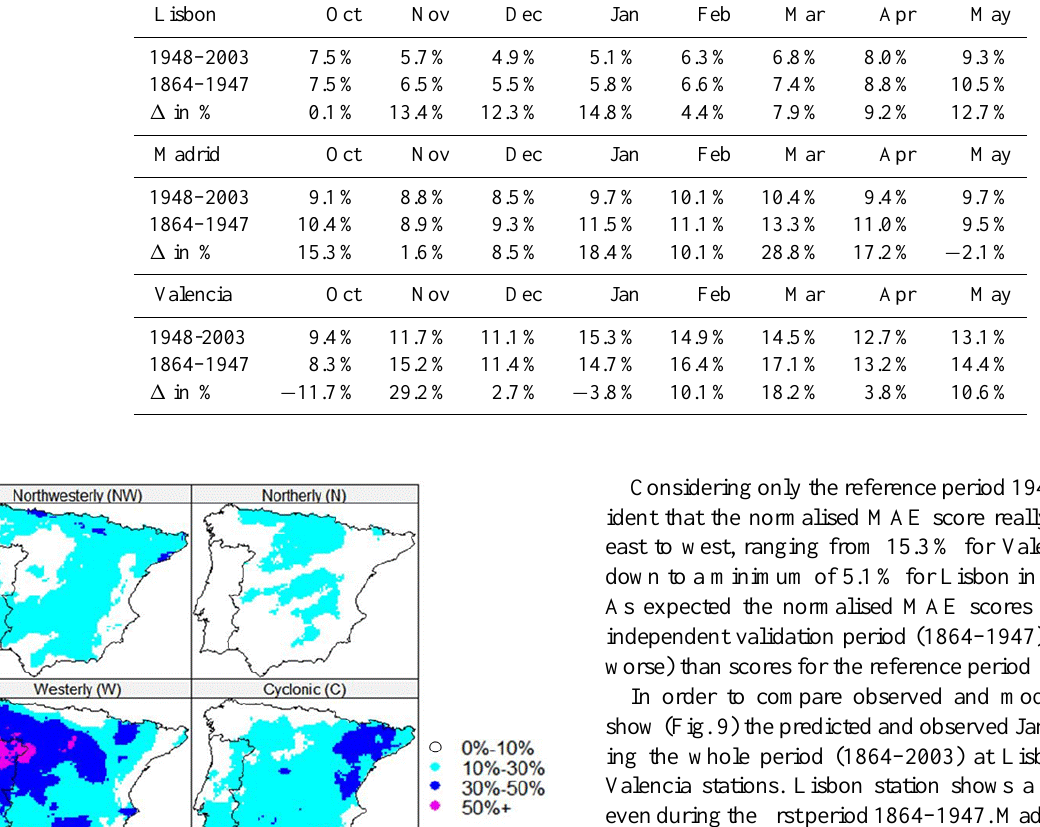
Table 3. Normalised monthly MAE values for Lisbon, Madrid and Valencia stations measured for two different validation periods: 1948– 2003 (same as calibration period) and 1864–1947. The percentage difference between the two validation periods appears in the third line of each station.